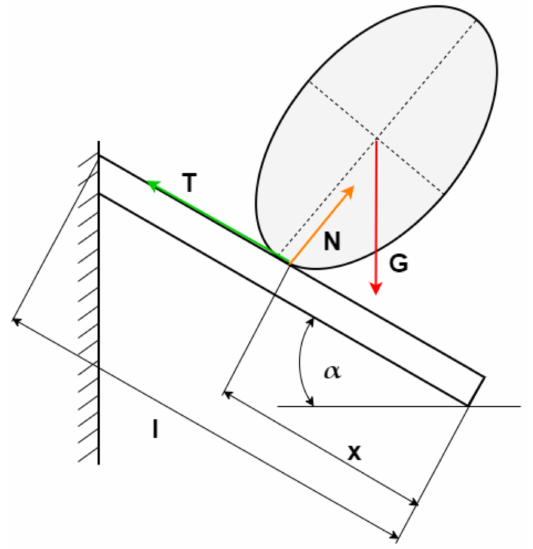
Figure 3. Scheme of forces affecting grains upon impact with the sensor surface, N–normal force, T–tangential force, G–gravitation force, α –tilt angle of sensor surface, x–the distance the grain collides with the sensor, l–the sensor